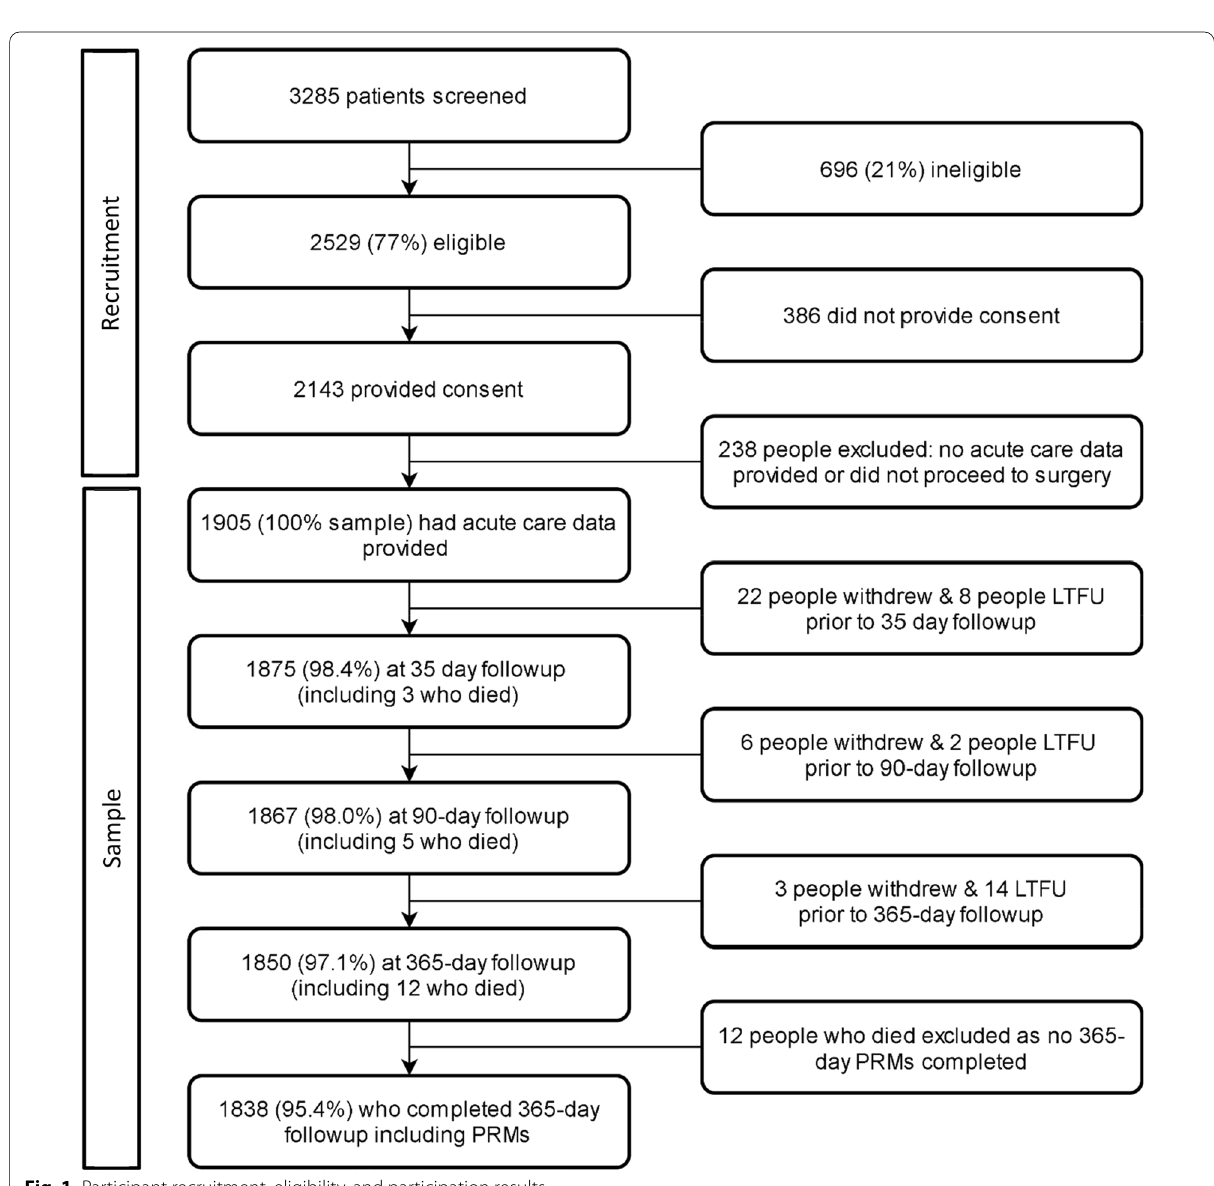
Fig. 1 Participant recruitment, eligibility, and participation